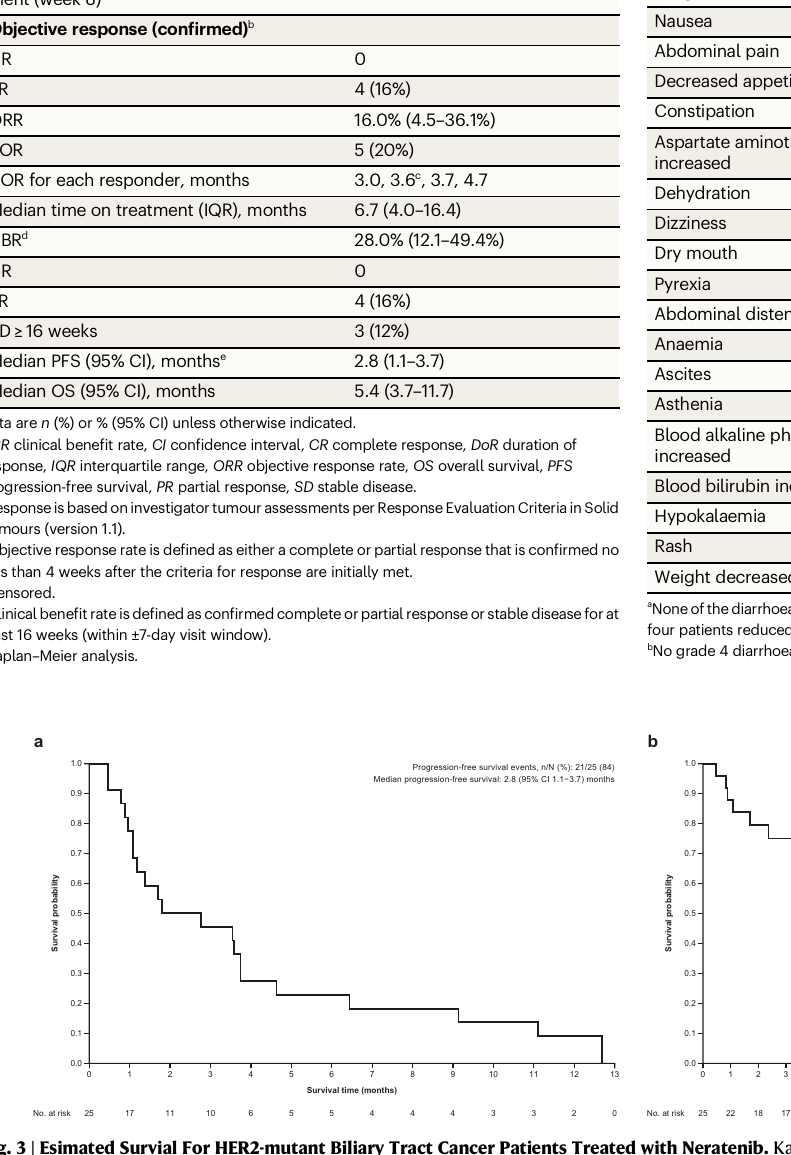
Fig. 3 | Esimated Survial For HER2-mutant Biliary Tract Cancer Patients Treated with Neratenib. Kaplan – Meier curves for a progression-free survival and b overall survival. Source data are provided as a Source Data fi le.